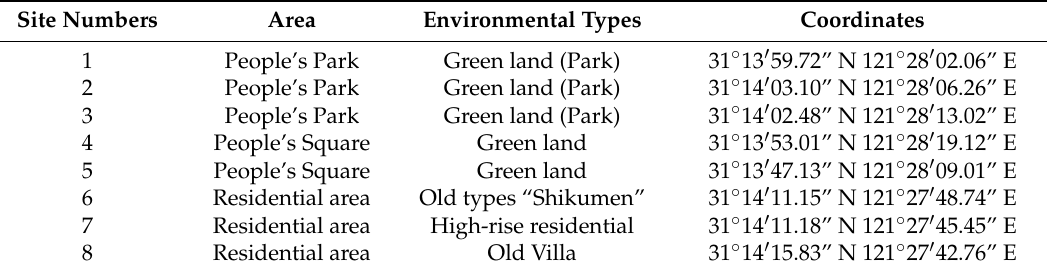
Figure 2. Regions and sites for mosquito surveillance in downtown Shanghai (Huangpu district). Table 1. Geographical information of the eight mosquito surveillance sites.